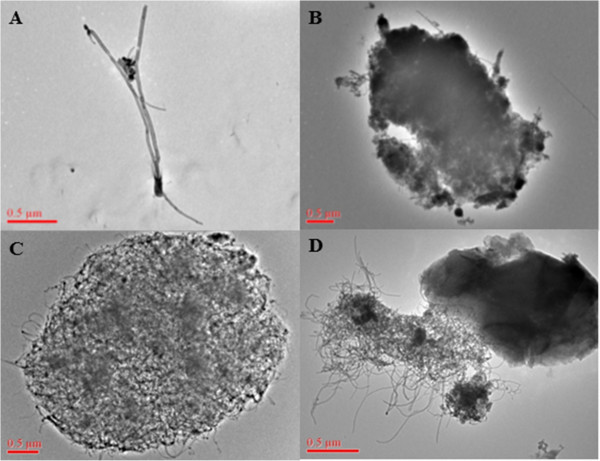
Images of multi-walled carbon nanotubes collected from facilities. Electron microscopy of filters collected from personal breathing zone sampling showed exposures can range from dispersed panel (A) to more agglomerated panel (B-D).